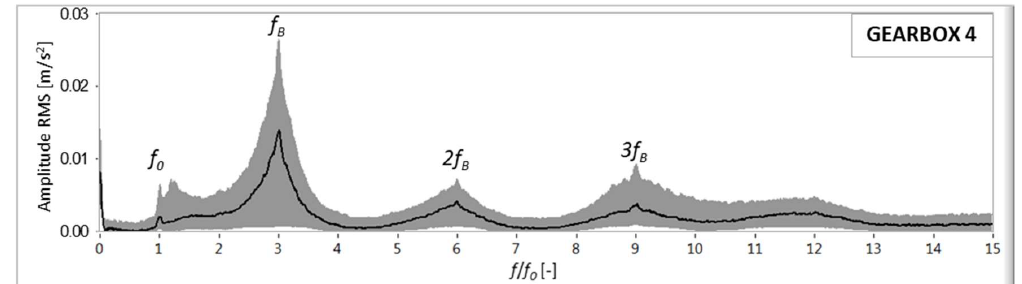
Figure 8. Median spectrum (black line) and amplitude levels between 25th and 75th percentiles (grey region) of the low frequency vibrations measured in the axial direction on the gearbox.